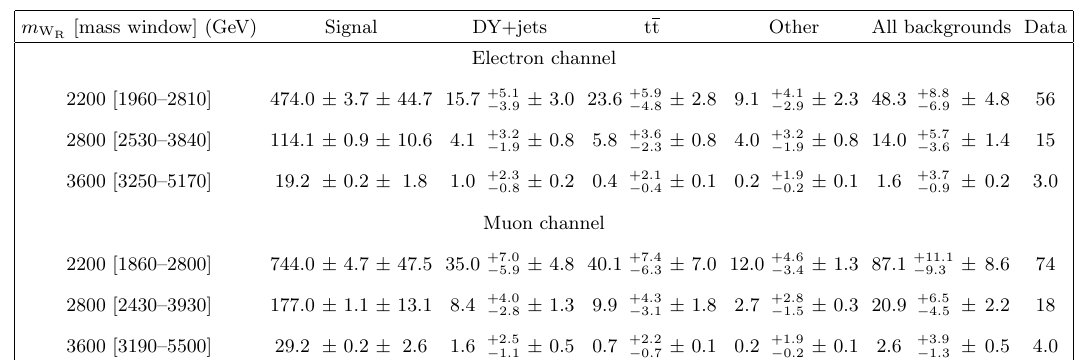
Table 4 . Number of expected events for signal, DY+jets, tt, Other, and All backgrounds, as well as the observed number of events in di(cid:11)erent W R mass windows. All uncertainties are included in the expected number of events. In each table cell, the entry is of the form (mean (cid:6) stat (cid:6) syst).